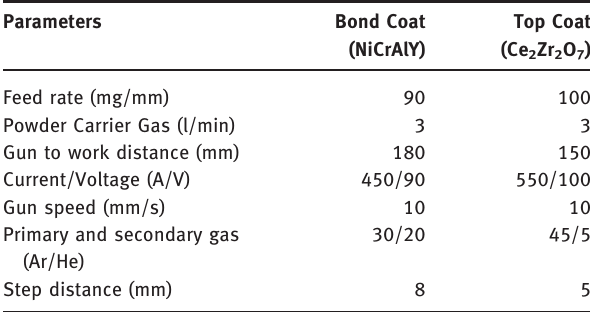
Table 2: Coating parameters used in preparation of APS bond and top